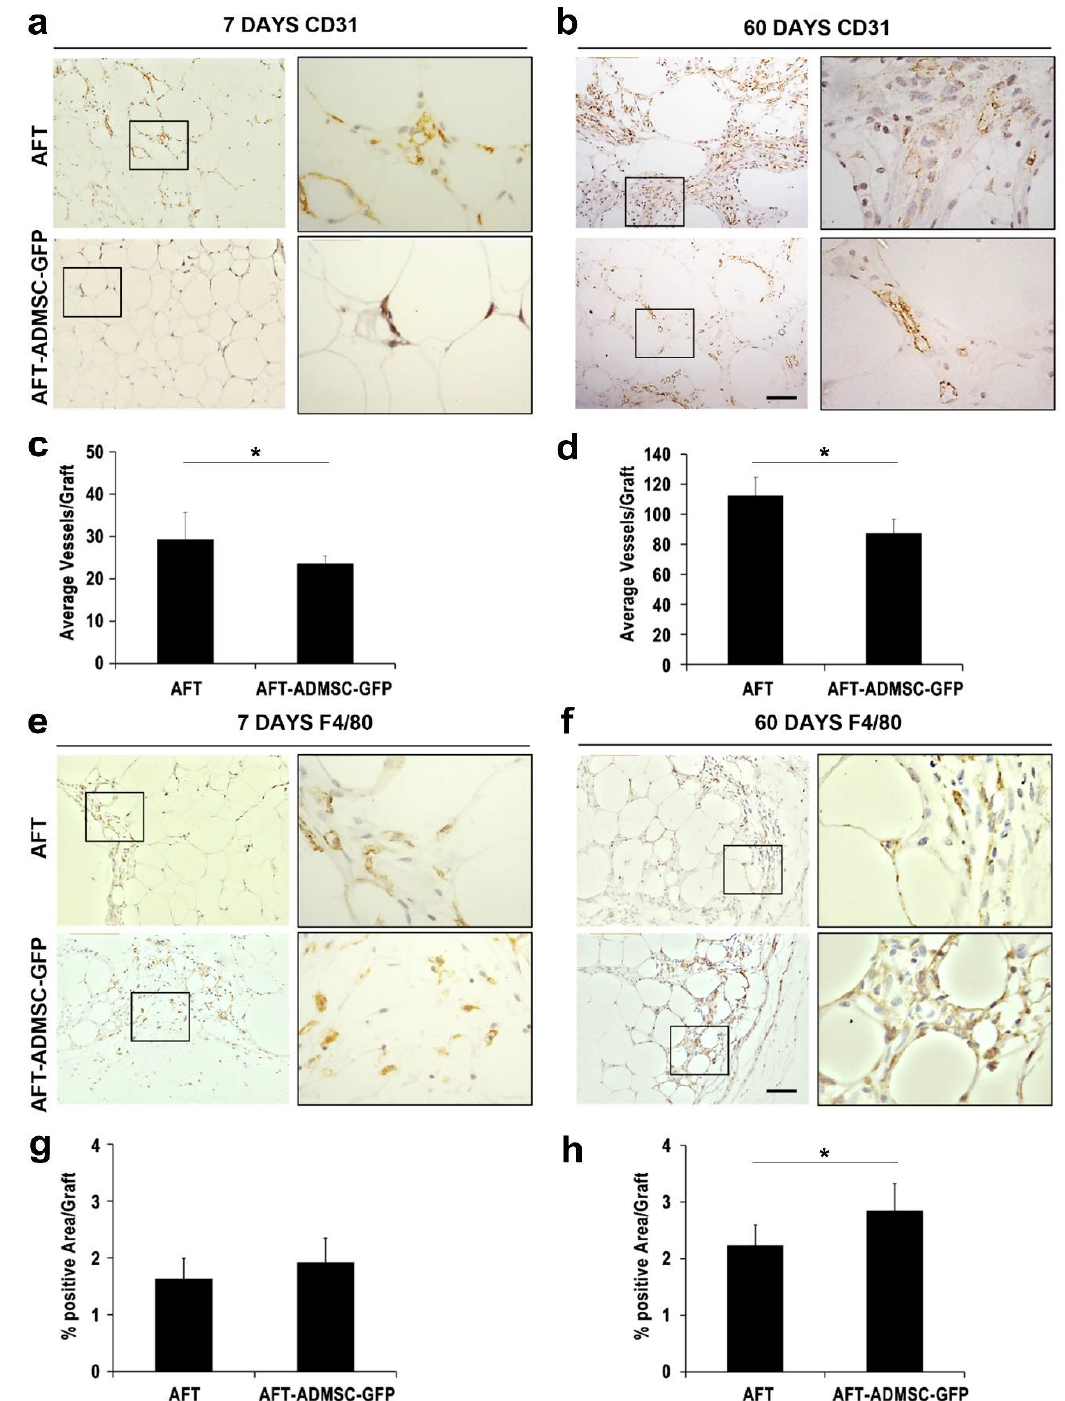
Figure 5. Proangiogenic and pro-inflammatory characterization of AFT-ADMSC-GFP: ( a , b ) im- munohistochemistry for CD31 in the AFT samples (upper panel and inset) and in the AFT-ADMSC- GFP grafts (bottom panel and inset) at 7 days and 60 days after transplantation; ( c , d ) quantitative measurement of CD31-positive vessels for the AFT and AFT-ADMSC-GFP specimens, * p < 0.05; ( e , f ) immunohistochemistry for F4/80 in the AFT samples (upper panel and inset) and in the AFT- ADMSC-GFP grafts (bottom panel and inset) at 7 days and 60 days after transplantation; ( g , h ) quan- tification of the F4/80-positive area/graft, respectively, at 7 days and 60 days post-engraftment per- formed using Image J software (NIH), * p < 0.05; n = 7. Scale bar = 100 µm.